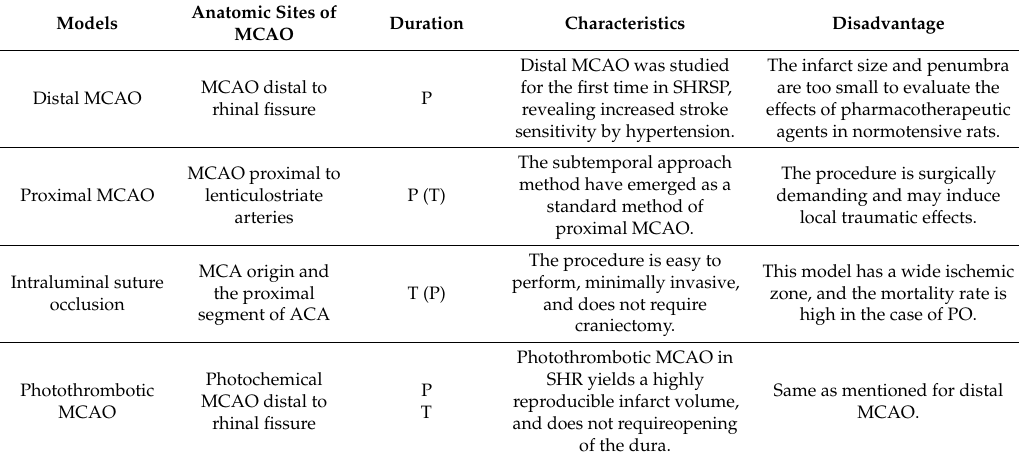
Table 1. Experimental models of